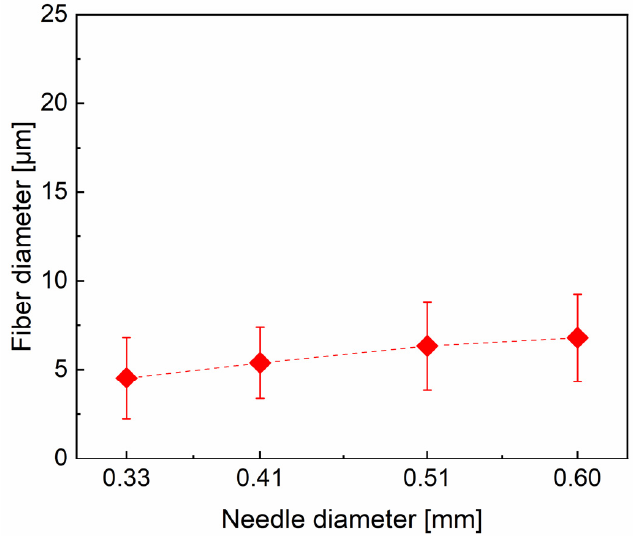
Figure 4. Plot of PVA fiber average diameter as a function of the nozzle size: The inner diameter of 0.33 mm, 0.41 mm, 0.51 mm and 0.6 mm correspond to needle 20#, 21#, 22#, and 23#, respectively.